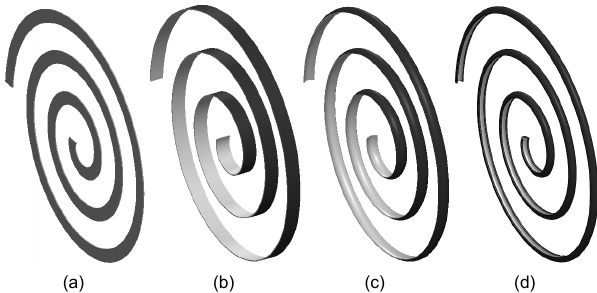
Figure 3. The four distinct cross-section shapes are swept uni- formly over the spiral basic curve giving the spatial geometries of the springs.